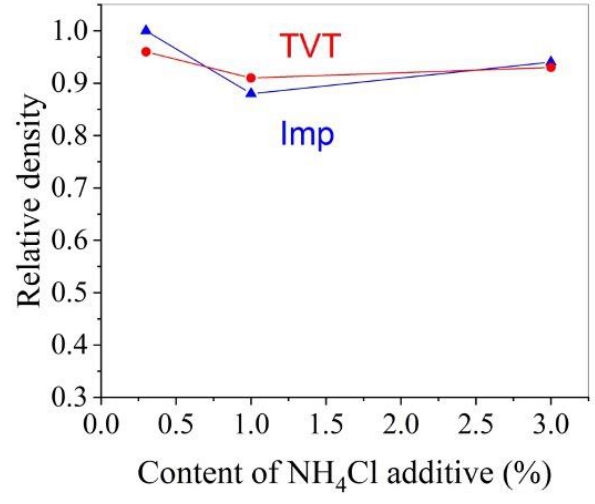
Figure 11. Effect of AmCl content and powder activation method on the relative density of CS ceramic samples: red line, circles - TVT method (indicated as TVT); blue line, triangles - impregnation method (indicated as Imp).